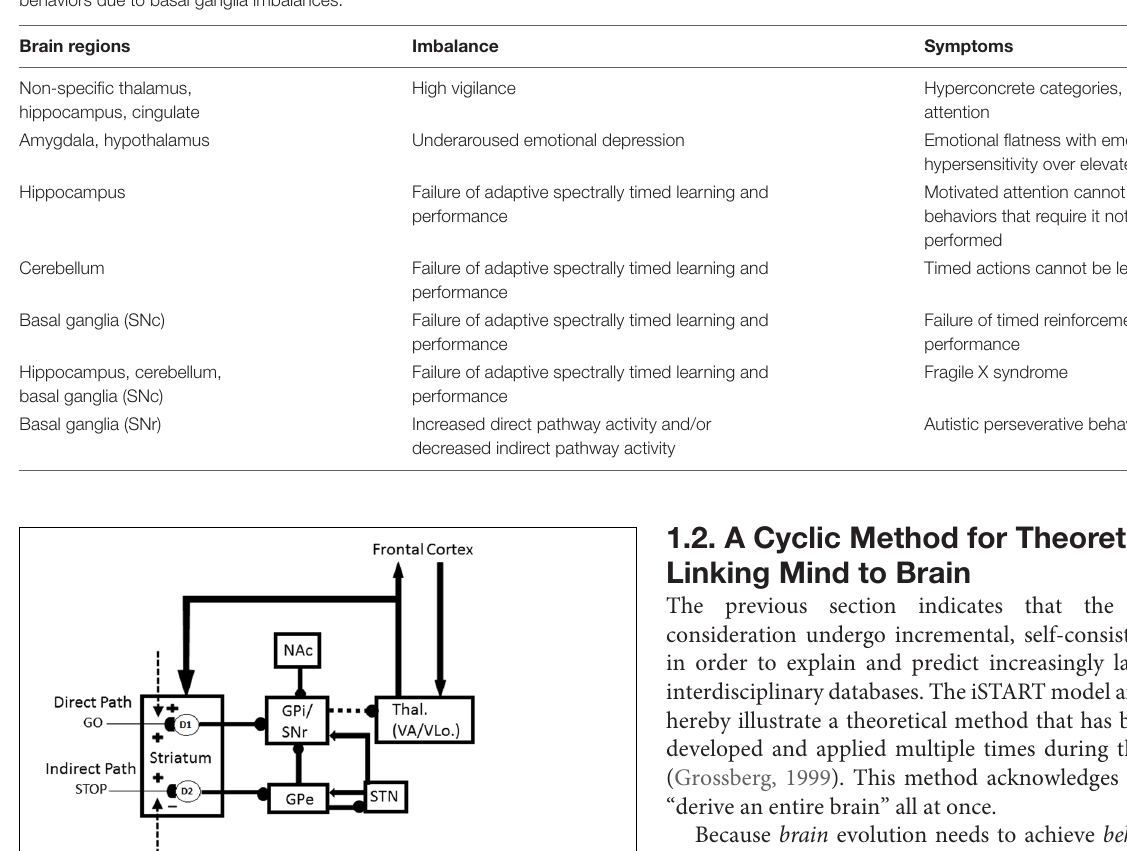
TABLE 1 | Brain processes, their imbalances, and the behavioral symptoms that they cause in the iSTART model, enhanced with the current results about perseverative behaviors due to basal ganglia imbalances.